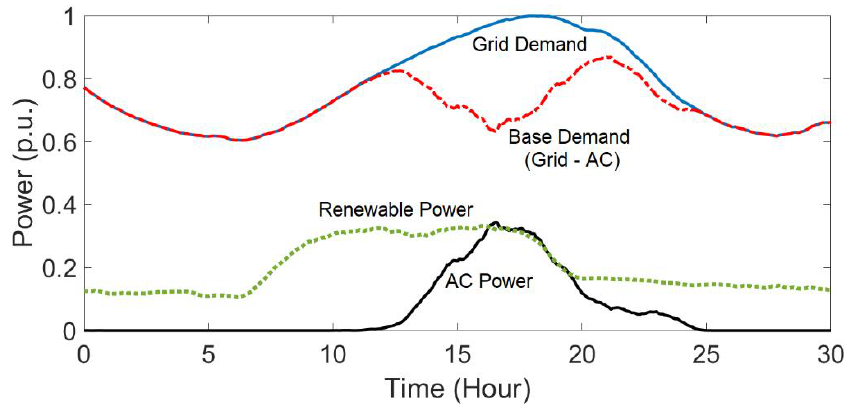
Figure 19. Total grid demand and renewable power obtained from the California Independent System Operator (CAISO), as well as the aggregate AC power and computed base demand for a daily cycle simulation.